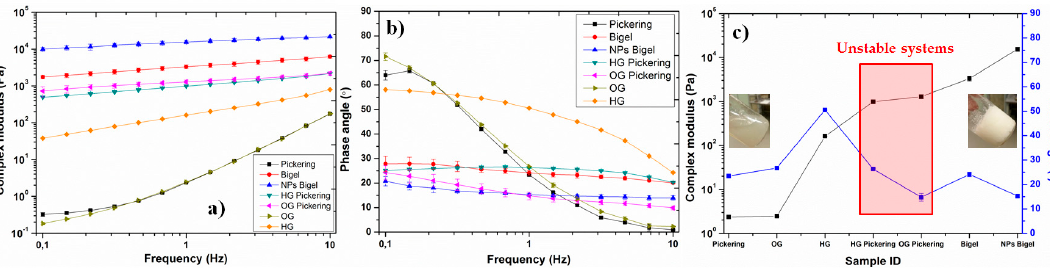
Figure 2. ( a ) Complex modulus and ( b ) phase angle as a function of frequency for different oil/water systems, and ( c ) values of complex modulus and phase angle at 1 Hz for different investigated samples (bars represent standard deviation).